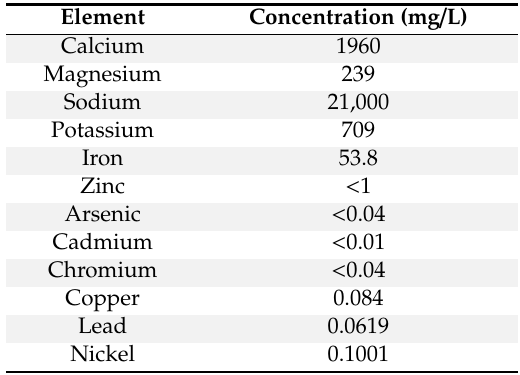
Table A3. Fracking wastewater composition used in the greenhouse study.